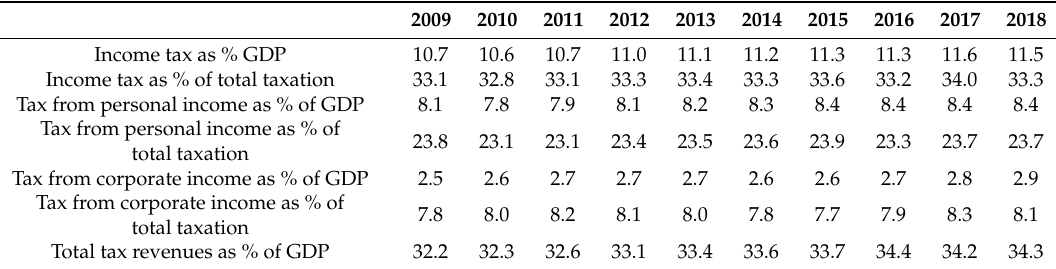
Table 1. Selected tax revenues in OECD